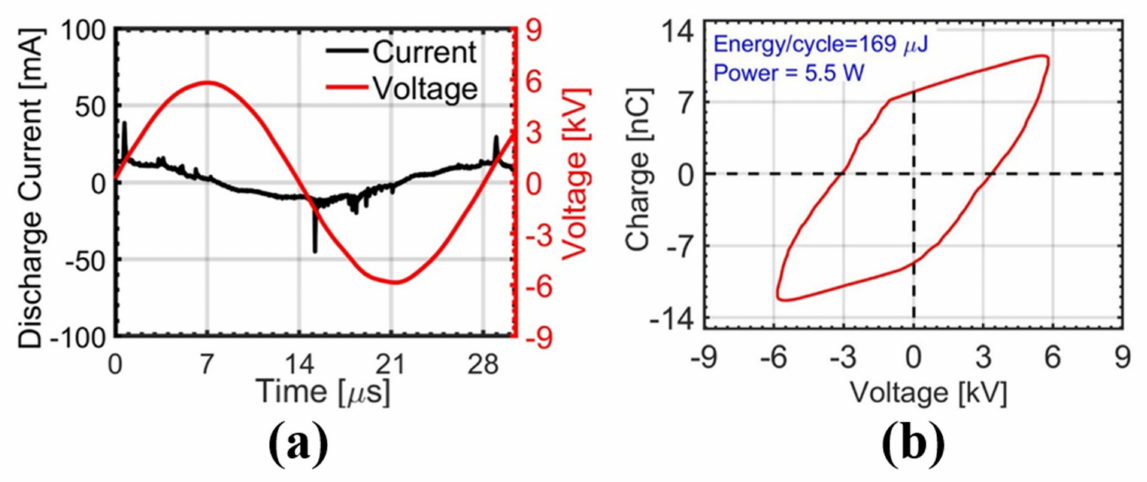
Figure 1. ( a ) Typical current and voltage profiles of the plasma discharge and ( b ) Lissajous plot corresponding to the plasma